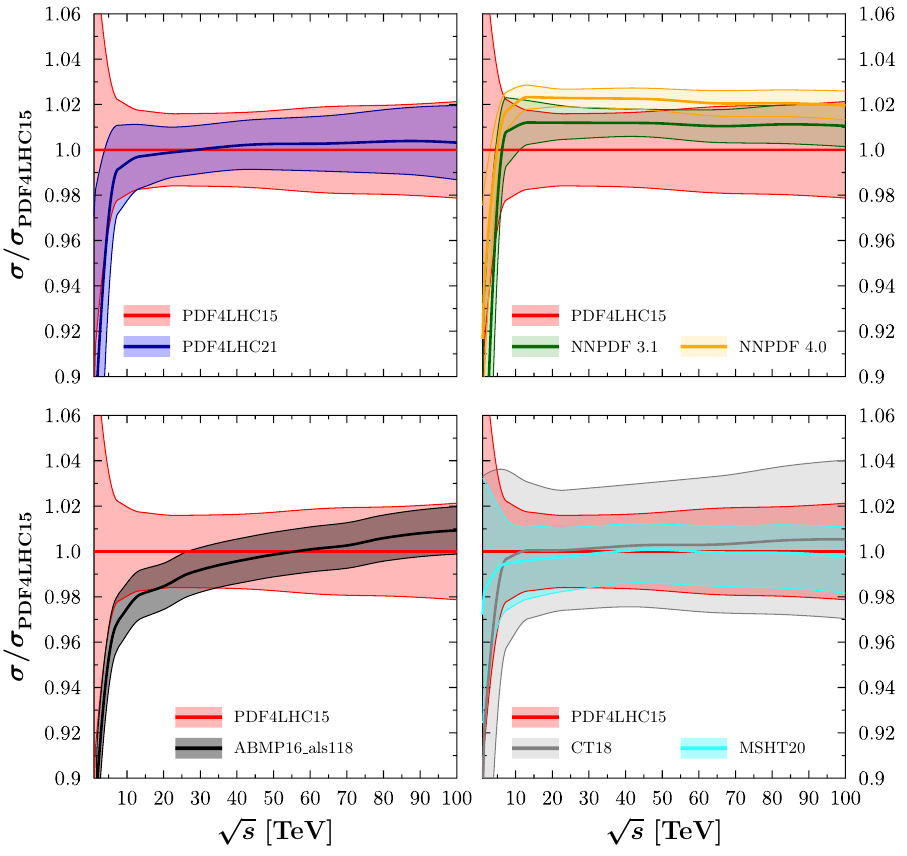
Figure 18 . Same as in figure 17, but for W − H inclusive cross